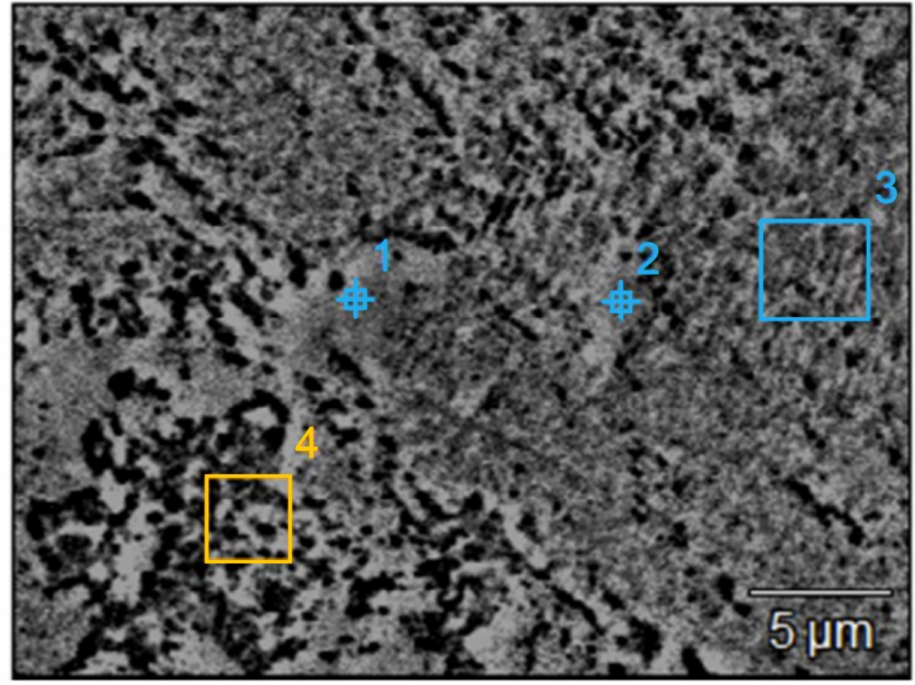
Figure 5. The area of microanalysis of the chemical composition of SEM sample after sintering (1,2- measurement points; 3,4- measurement